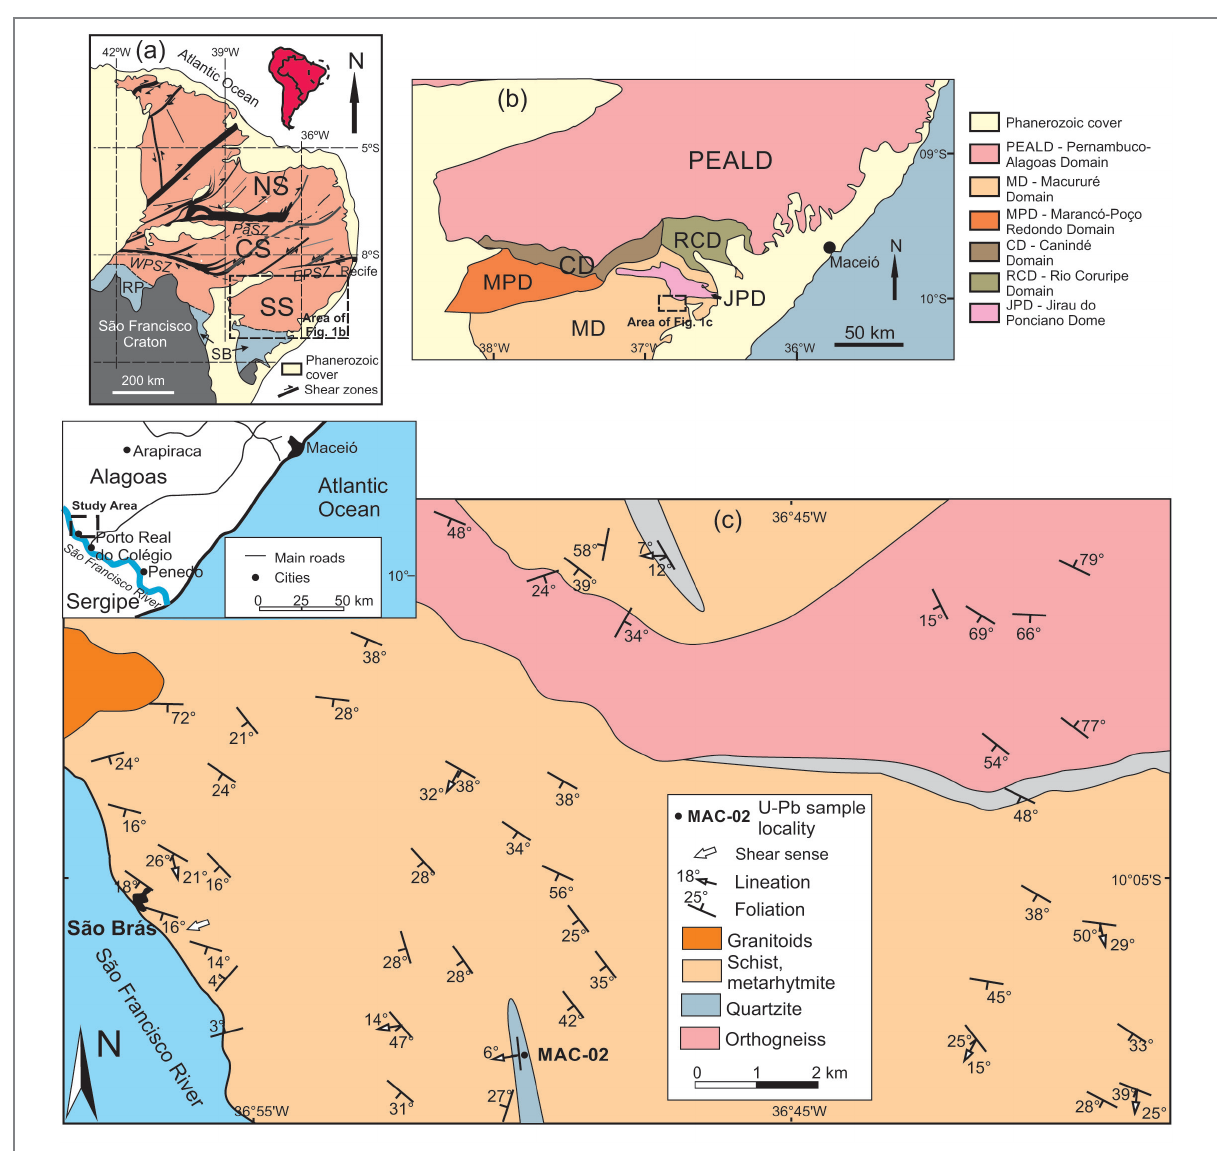
Figure 1 - Geotectonic setting and geographic location of the study area. (a) Sketch showing the subdivision of the Borborema Province in Northern (NS), Central (CS) and Southern (SS) subprovinces, highlighting the Sergipano (SB) and Riacho do Pontal (RP) belts bordering the São Francisco Craton. Shear zone systems: PaSZ, Patos; EPSZ, East Pernambuco; WPSZ, West Pernambuco. (b) Simplified geological map of the area outlined in (a) showing the subdivision of the eastern portion of the Southern Subprovince according to Mendes et al. (2009). Rectangle shows location of the study area. (c) Geological map of the study area. Inset shows its location in the State of Alagoas.